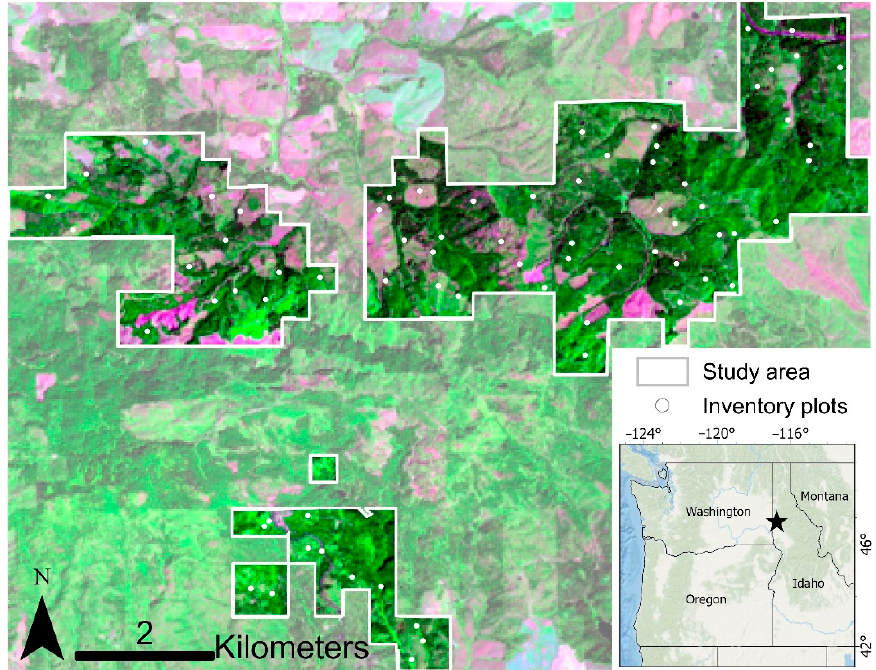
Figure 1. Location of the University of Idaho Experimental Forest study area and field inventory plots in north-central Idaho, USA. A Landsat 8 false color composite (red: B7, green: B5, blue: B4), acquired 26 July 2020, is used as background to highlight the variability of forest stands within the study area. Pink-colored areas represent recently harvested areas and newly planted stands. Light-green areas represent younger, more homogenous stands. Dark-green speckled areas represent older, more heterogeneous stands.